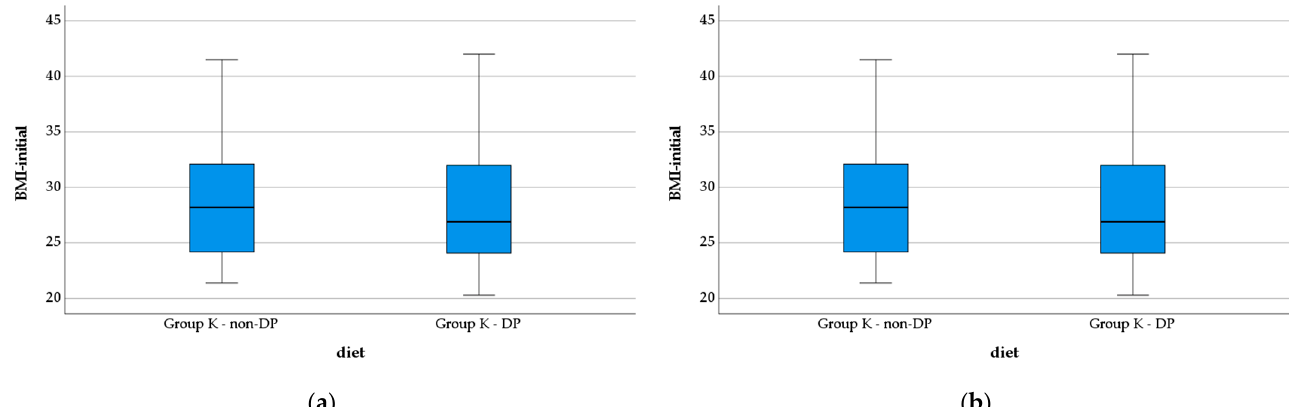
Figure 6. Evolution of the hemoglobin level in the study groups: ( a ) initial vales; ( b ) final values. *, extreme outliers; o, mild outliers.